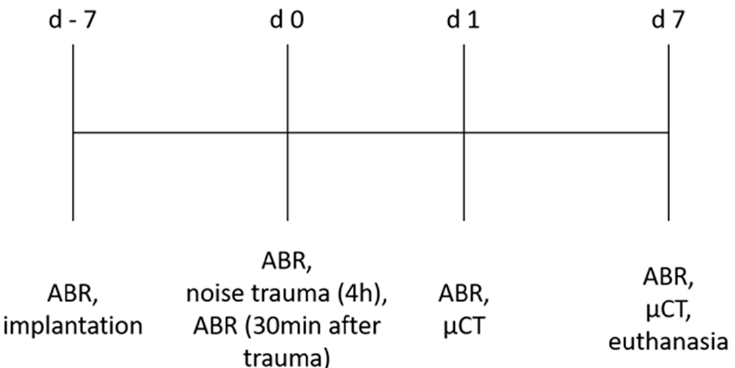
Figure 2. Experimental set-up. Timeline of the individual measurements and interventions. performed under general anesthesia (intramuscular medetomidinhydrochloride 0.2 mg/kg, midazolam 1 mg/kg and fentanyl 0.025 mg/kg), following pre-anesthetic sedation (oral diazepam 4 mg/kg). Areas to be incised were locally infiltrated with prilocaine. To reduce pain and to prevent infections, the animals subcutaneously received 0.2 mg/kg meloxicam and 10 mg/kg enrofloxacin. Euthanasia was performed via intracardiac injection of no less than 300 mg/kg pentobarbital. For details concerning the medical treatment, one can refer to Appendix